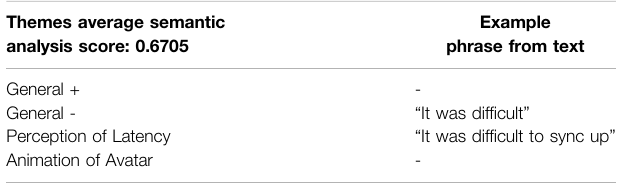
TABLE 3 | Cluster 1.